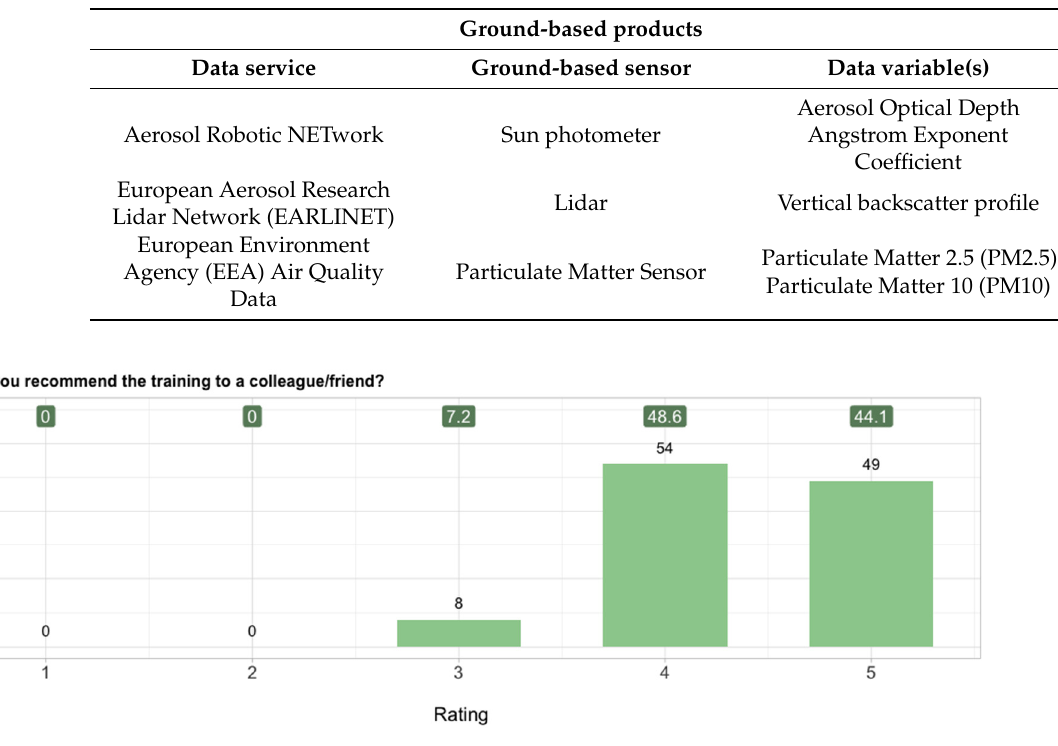
Figure A1. Rating by training participants ( n = 111) whether they would recommend the training to a friend/colleague. Rating levels were from 1 (low) to 5 (high). Bars indicate absolute numbers, labels on top indicate relative frequencies in %. Table A3. Categories built based on the open response question ‘What did you specifically enjoy or